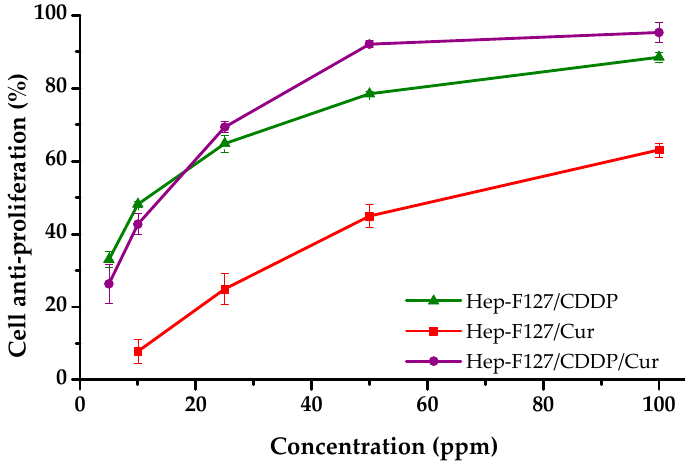
Figure 5. Inhibition of MCF-7 cancer cell growth of the drug delivery systems versus bioactive Cur and/or CDDP